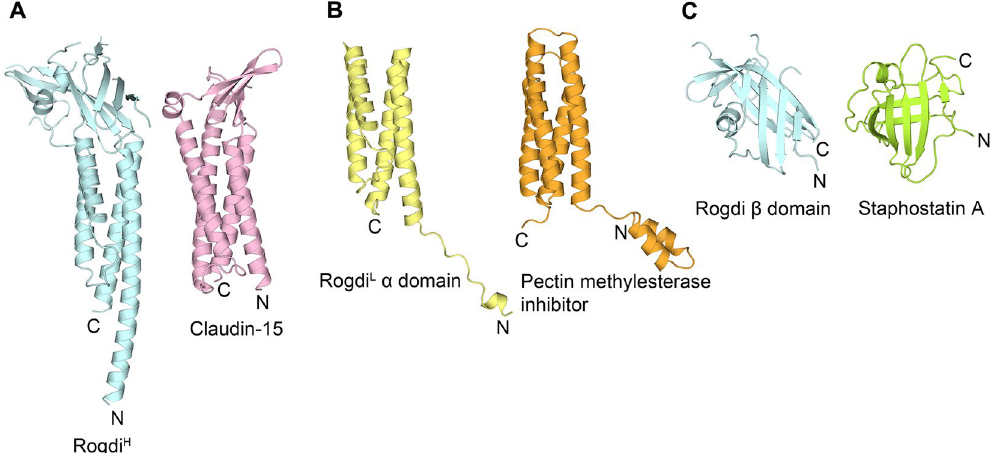
Figure 5. Structural Comparison between Rogdi and Claudin-15. Structural comparison of Rogdi and proteins with a similar fold, shown in the same orientation. Full-length Rogdi H most closely resembles Claudin-15 ( A , PDB ID: 4P79), an essential component of tight junctions. Rogdi L shows structural similarity with pectin methylesterase inhibitor ( B , PDB ID: 1X8Z) and staphostatin A ( C , PDB ID: 1OH1).